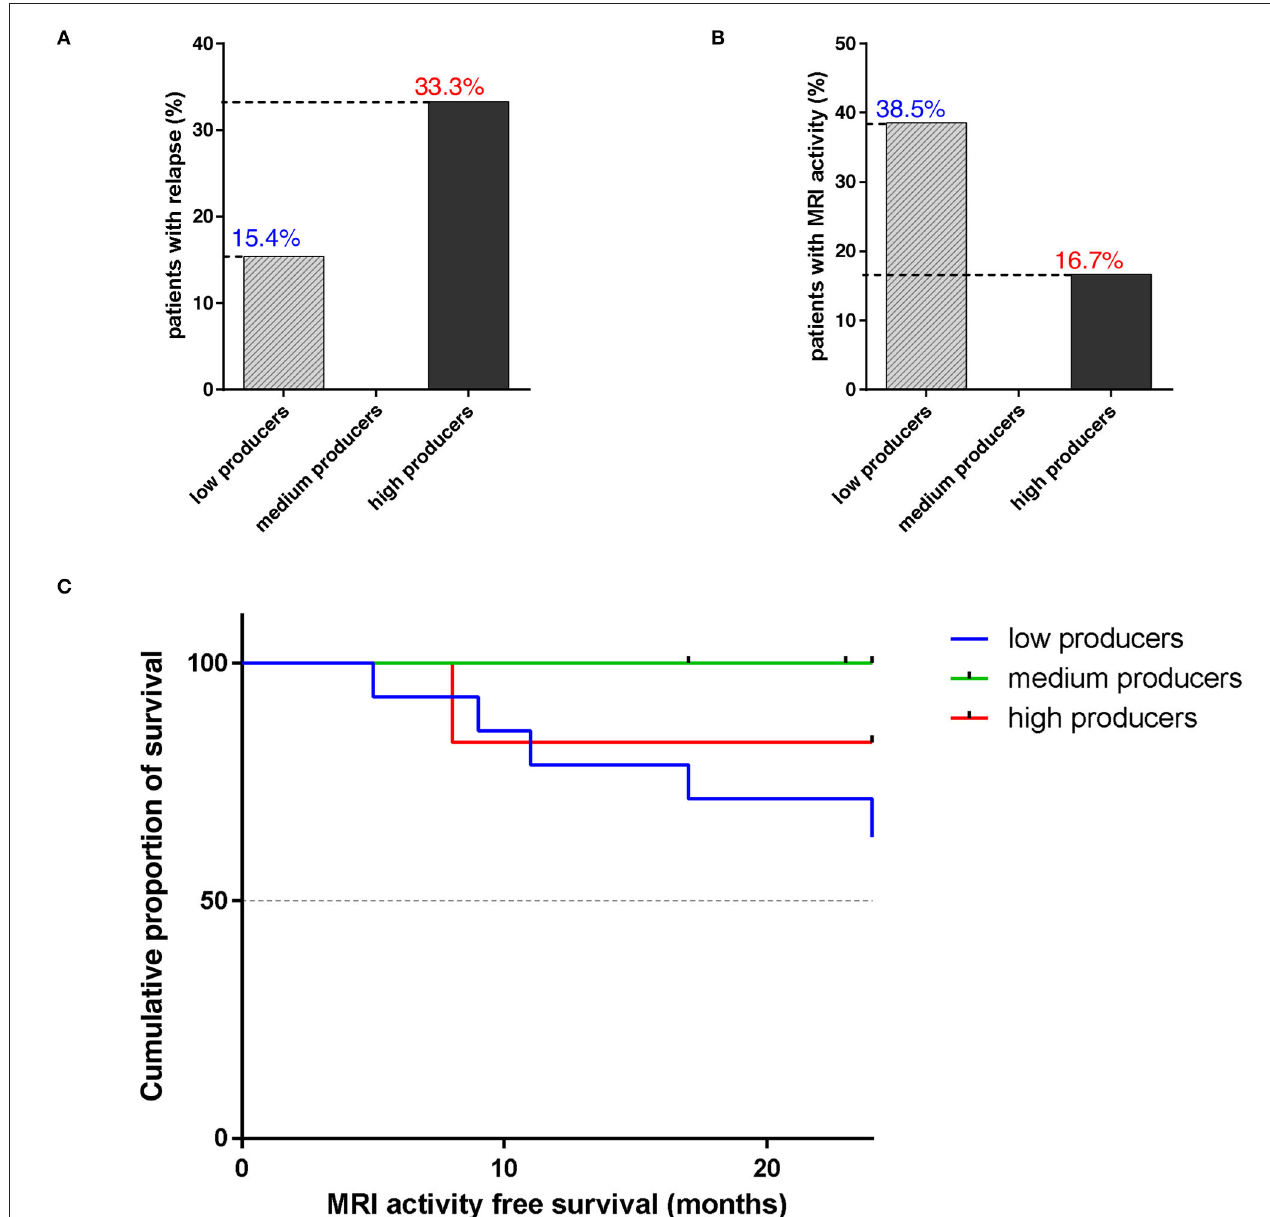
FIGURE 4 | The majority of high and medium sHLA-G producers are free from disease relapse and MRI activity after 24 months of natalizumab. (A) Percentage of patients with RRMS, divided into low ( N = 13; 1/14 was lost from follow-up at 17 months), medium ( N = 6; 1/7 was lost from follow-up at 17 months), and high ( N = 6) sHLA-G producers, who experienced a disease relapse during NTZ treatment. Chi-square test was used. (B) Percentage of patients with RRMS, divided into low, medium, and high sHLA-G producers, who showed MRI disease activity during treatment. (C) Cumulative proportion of survival (percentage) from MRI activity of patients with RRMS over NTZ treatment (time from 0 to 24 months is reported on x-axis) for low (blue line), medium (green line), and high (red line) sHLA-G producers. Chi-square test was used.